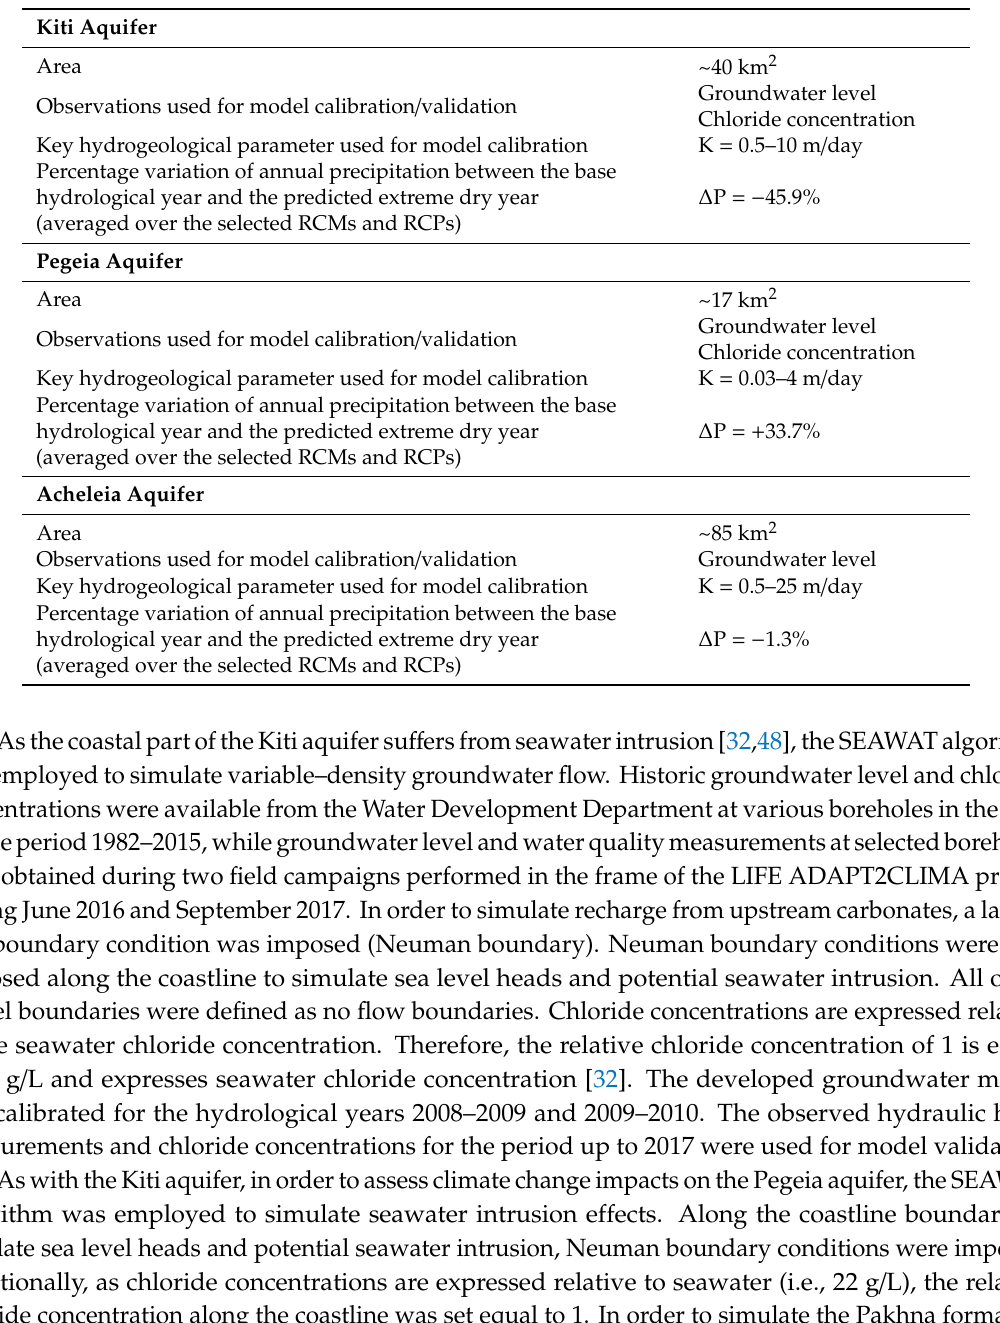
Table 1. Models’ key